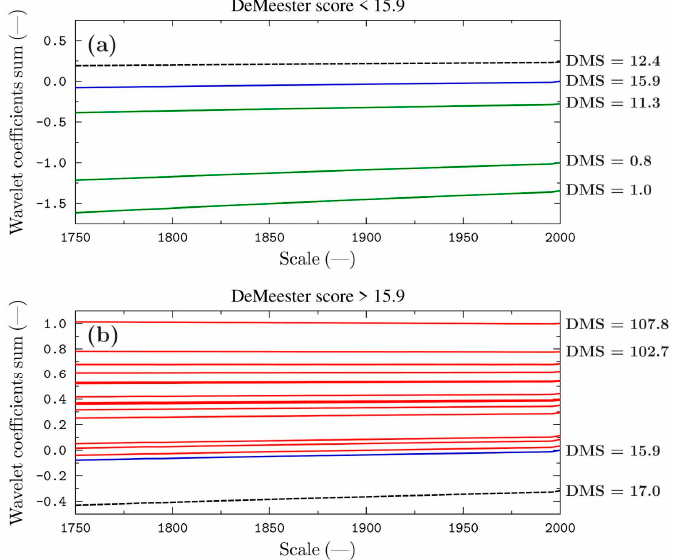
Figure 10. Curves representing rescaled sums of wavelet coefficients. Different colours indicate cases of calculated DeMeester score (DMS): ( a ) classification of healthy patient: blue line—baseline (DMS 15.9), green lines—healthy patient (DMS < 15.9), black dashed line—misclassified patients (DMS = 12.4); ( b ) classification of patients with reflux: blue line—baseline (DMS = 15.9), red lines—a patient diagnosed with GERD (DMS > 15.9), black dashed line—misclassified patients (DMS =